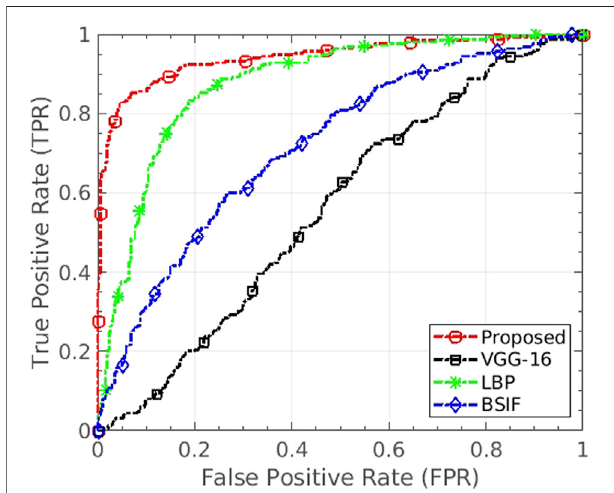
FIGURE 8 | ROC of the cross-database experiment where the algorithms are trained on Snapchat and tested on FaceApp database. The proposed algorithm shows generalizability in handling unseen distortion type